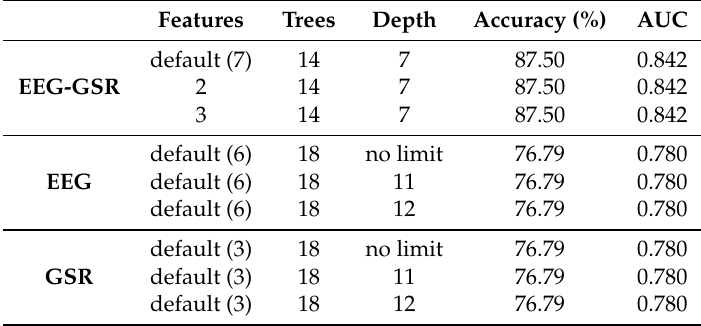
Table 5. RF hyperparameter tuning